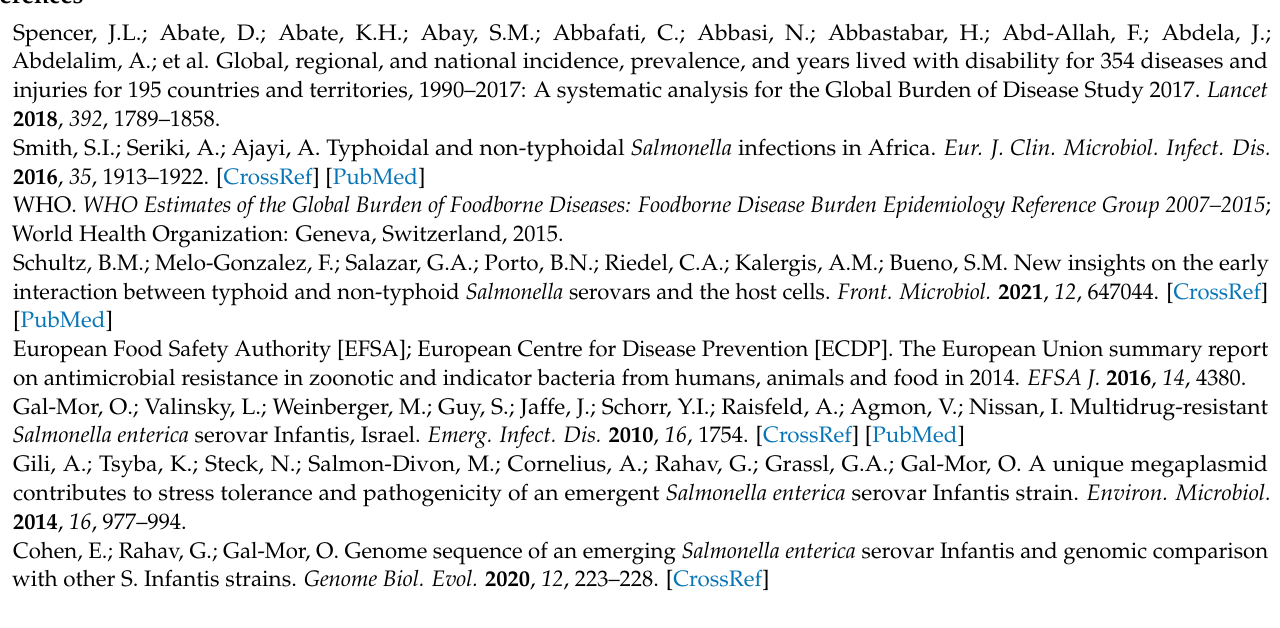
Table S2: COBB 500 Feed components and proximate composition of starter and grower diets; Table S3: Experimental